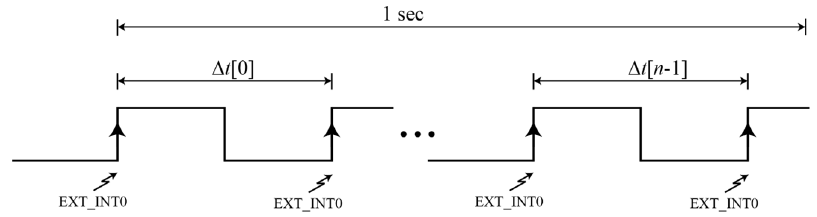
Figure 14. Events handled by the microcontroller for power-consumption estimation. A picture showing the developed smart-meter module is presented in Figure 15. The measurement board is mounted in the box with the plug on the back and the socket on the front face. The minimum, maximum, and current average are displayed next to the graphical representation of the load profile when the trace mode is activated (the sampling time is one second).